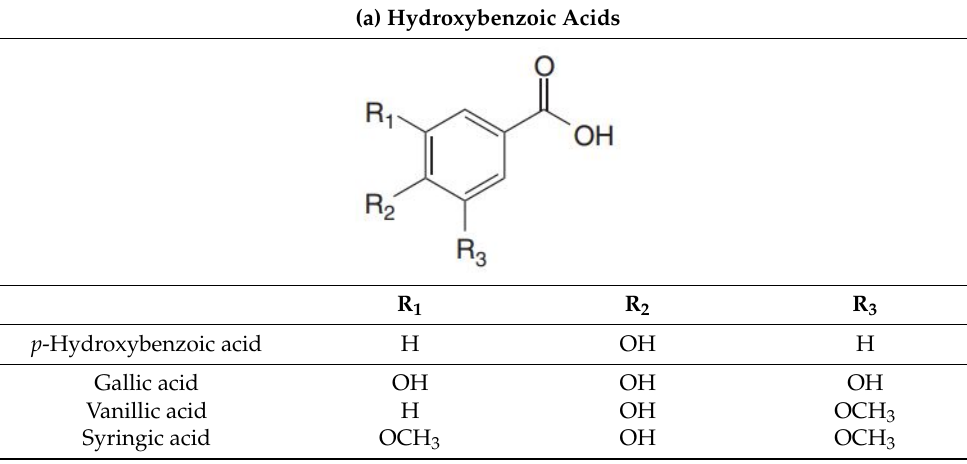
Table 1. Chemical structure of four hydroxybenzoic acids (a) and four hydroxycinnamic acids (b).